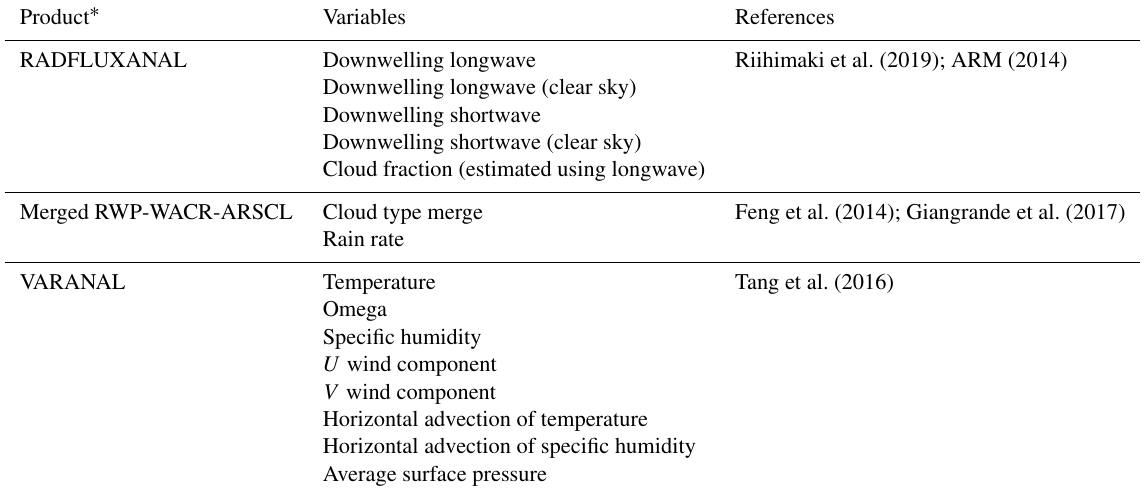
Table 1. Summary of observational data (GoAmazon 2014/15).